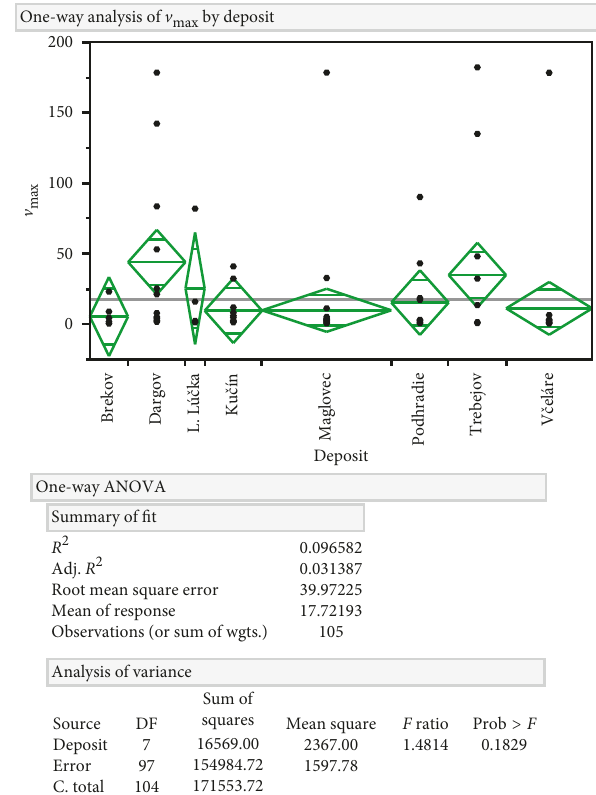
Figure 4: Analysis of v